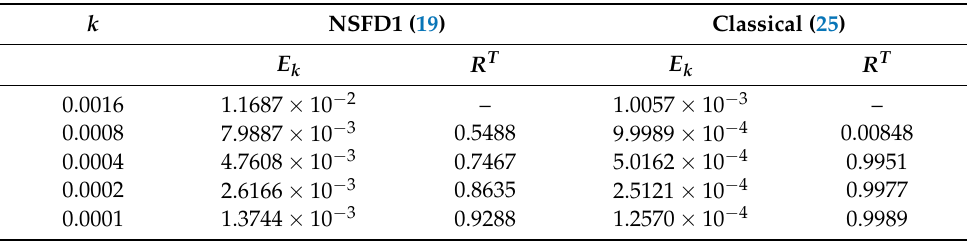
Table 3. Rate of convergence in time using experiment 3 for NSFD1 and classical schemes for h = 0.02 at time t =